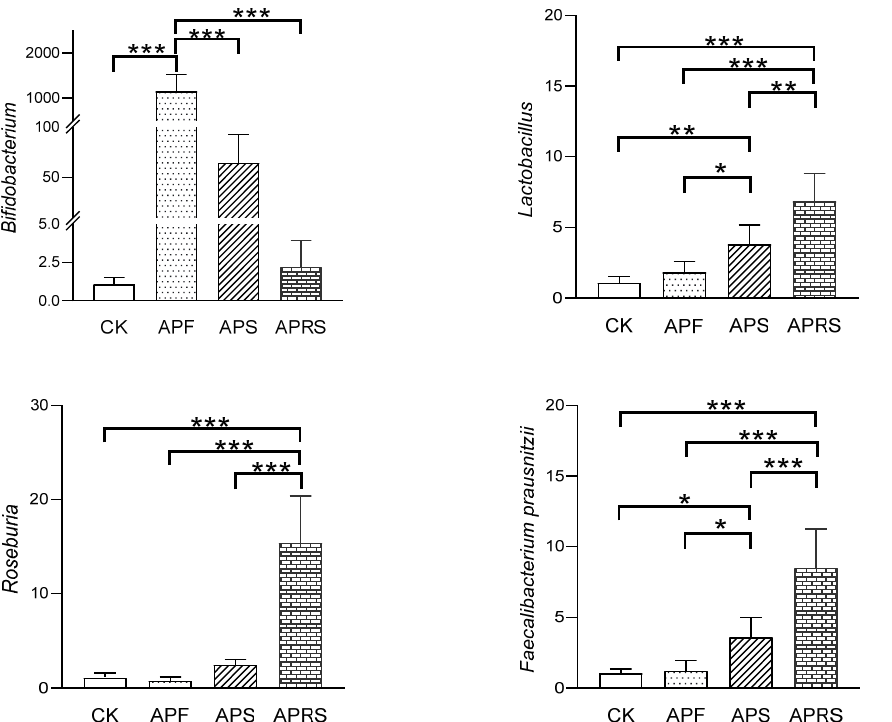
Figure 4. Changes in the relative abundances of Bifidobacterium , Lactobacillus , Roseburia , and Faecalibacterium prausnitzii under dietary intervention (* p < 0.05, ** p < 0.01, *** p < 0.001, one-way ANOVA with LSD test).